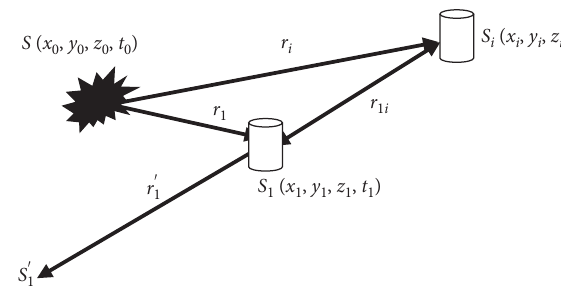
Figure 1: Position relationship between the seismic source and the